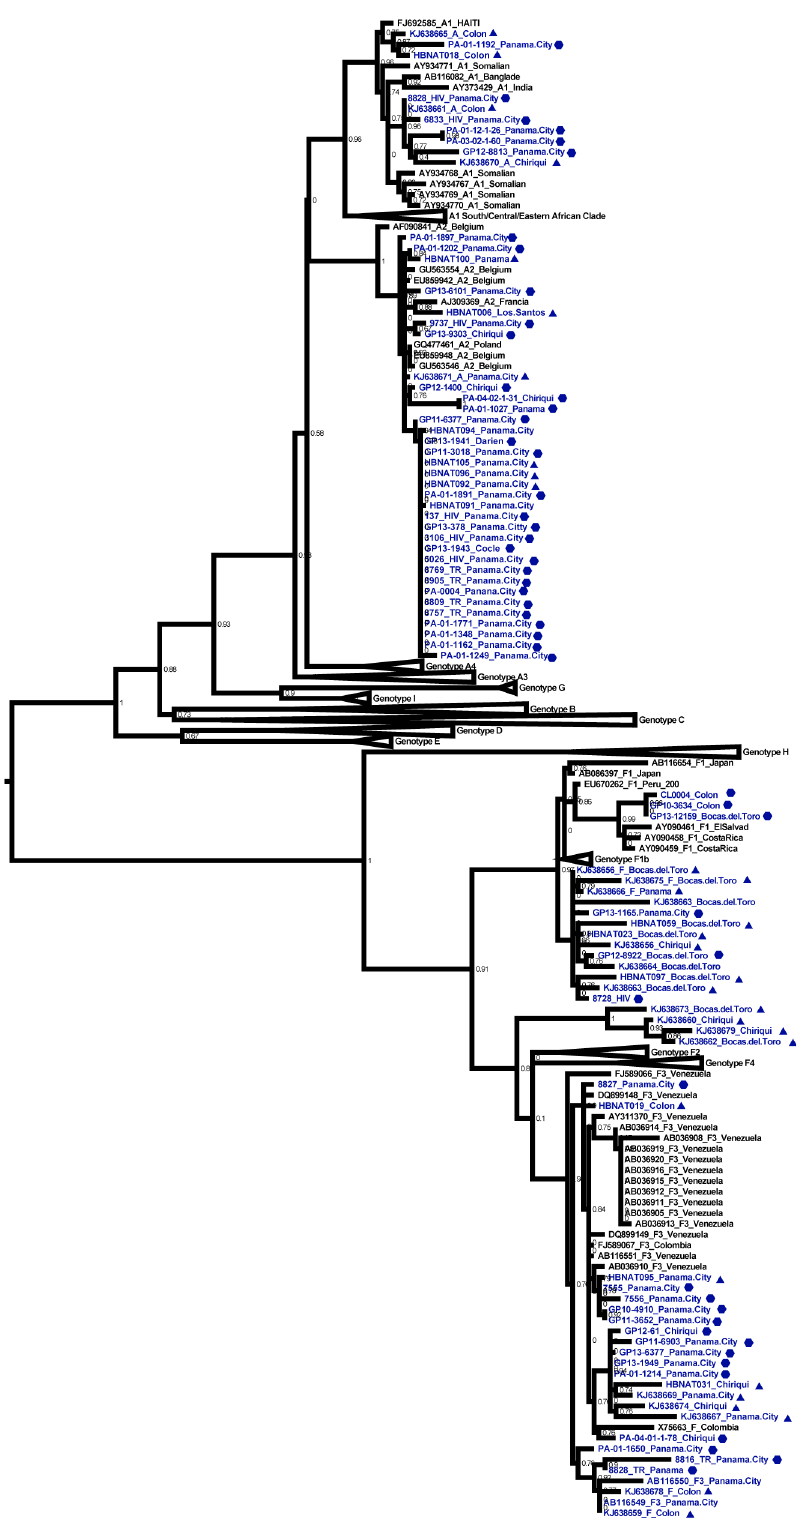
Fig 1. Maximum Likelihood tree of HBV Panamanian sequences. The tree is based on HBV partial PreS2-S region (~820pb), using reference sequences of each genotype (A-I) (n = 280) and sequences of